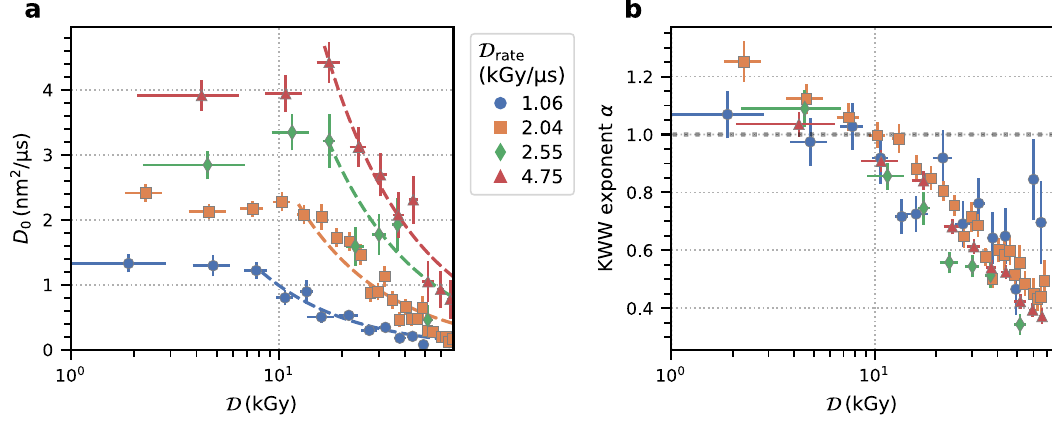
Fig. 4 | Dynamical parameters. a Diffusion coef fi cient, D 0 , as a function of initial dose fordifferent dose rates indicated by the color. The dashedlinesare guidesto